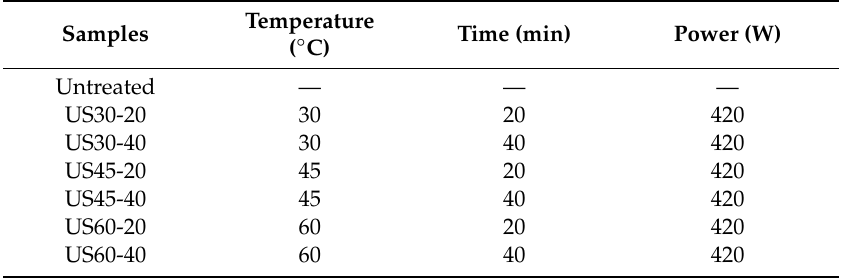
Table 1. Processing conditions used during ultrasound treatments. Temperature Time (min) Power Samples ( ◦ C)